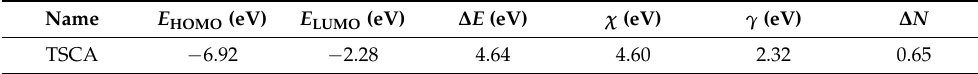
Table 4. Derived quantum chemical parameters for TSCA calculated by the DFT/B3LYP method.